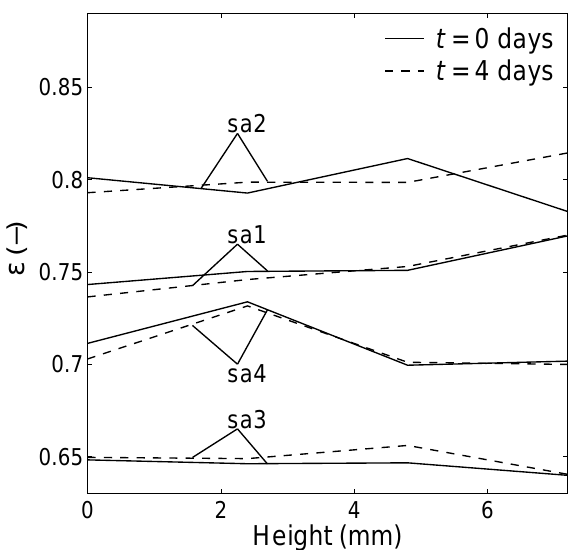
Figure 9. Spatial SSA profile of the scanned area at the beginning and at the end of each experiment. The spatial variability within the reconstructed volume was measured in four discs of 7 . 2mm × 7 . 2mm × 1 . 8mm.